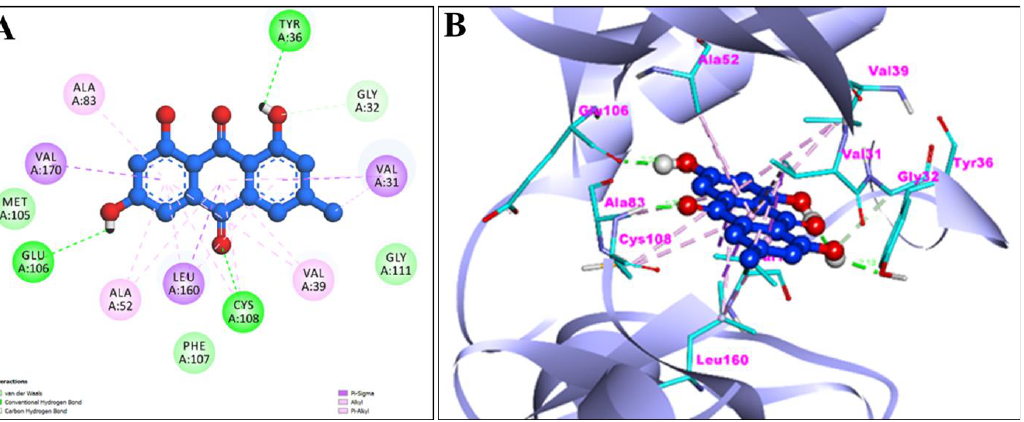
Figure 5. 2D ( A ) and 3D ( B ) representation of interaction of emodin (blue color) and human Traf2- and Nck- interacting protein kinase (purple color with ribbon pattern) (PDB:2X7F).